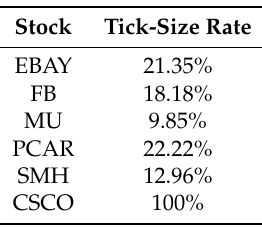
Figure 5. General Compound Hawkes Process with 2 fixed Dependent Orders model fitting results. Table 2. Tick-size rate.